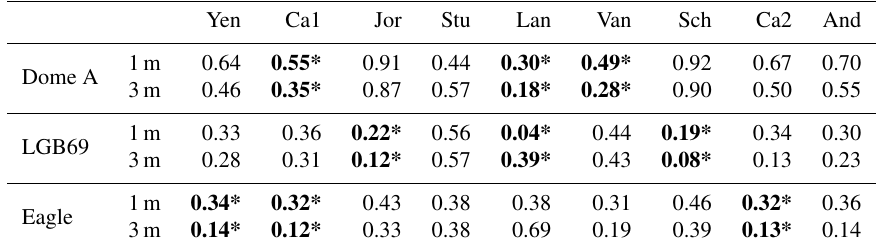
Table 1. Deviation ( σ 2 ) of | T model − T obs | (K) for different density-dependent empirical relationships at 1 and 3m for three stations. The three overall best relationships for different depths are shown using “*”. Yen